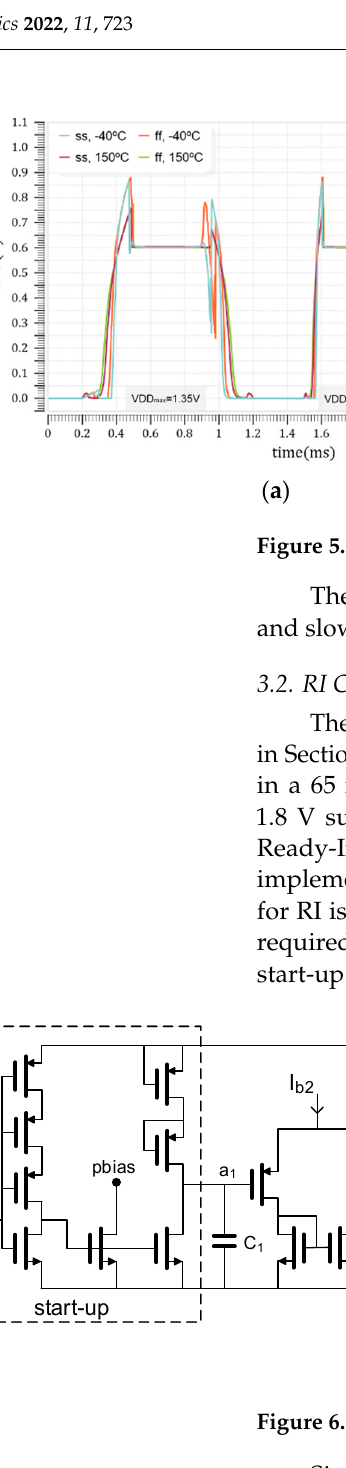
Figure 4. The BGR#1 (22 nm, 1.8 V) Ready-Indication for different power-up and power-down con- ditions at a typical temperature (27 °C). ( a ) Important input-output voltages and ( b ) internal critical voltages used for comparison.